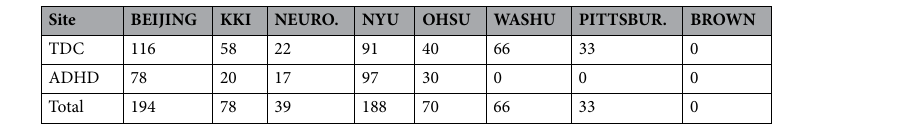
Table 4. Number of subjects per